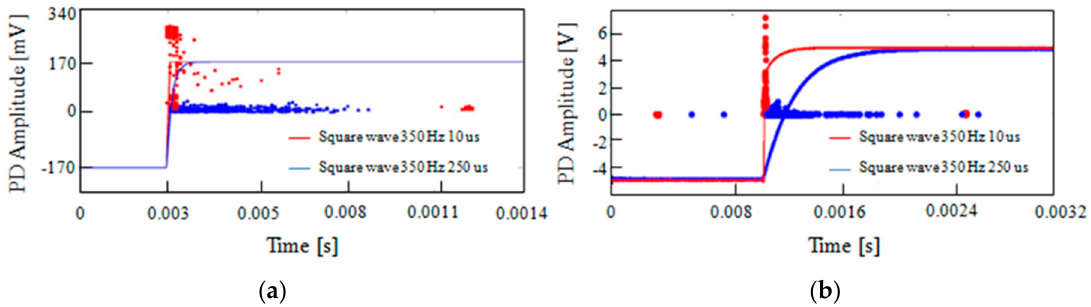
Figure 17. The positive discharge obtained with ( a ) PASPD and ( b ) STOPD systems obtained with square waves of 350 Hz and 10 μ s and 250 μ s rise times.